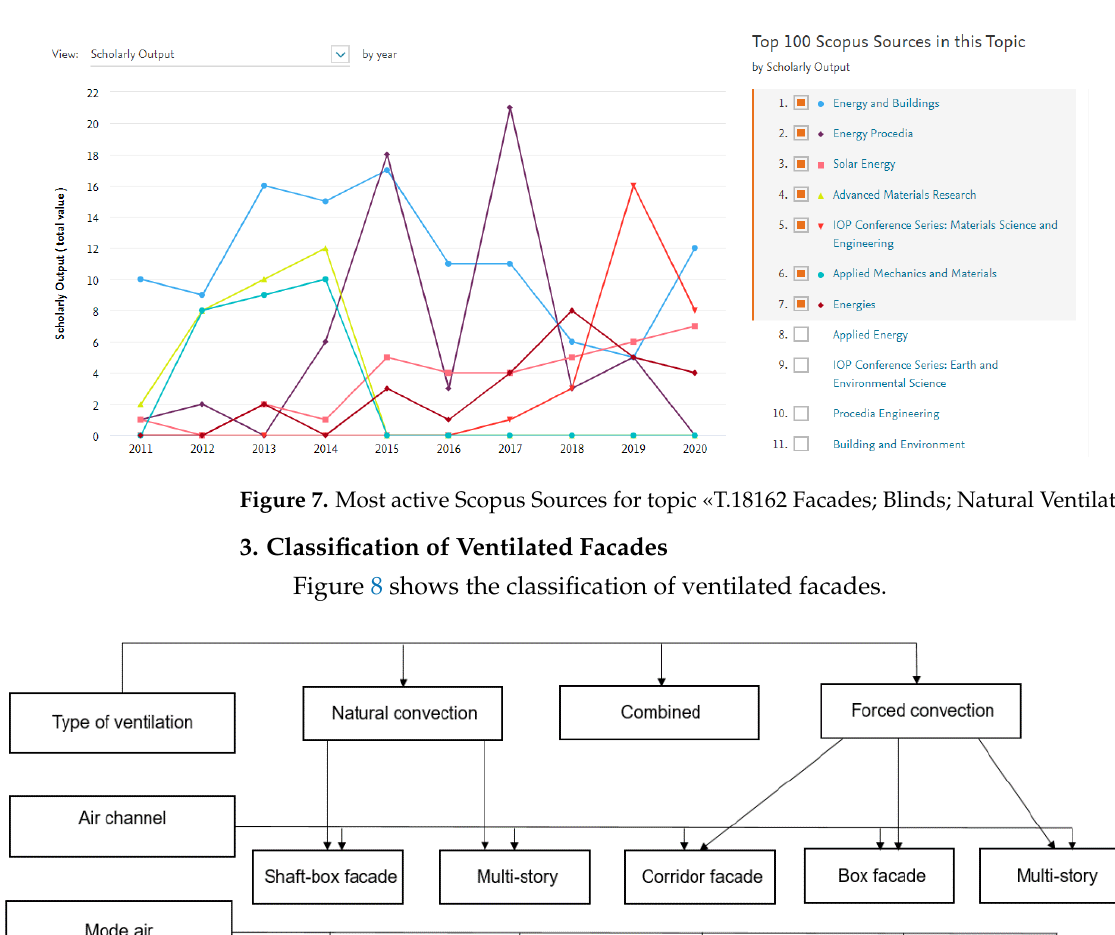
Figure 8. Classification of ventilated facades.